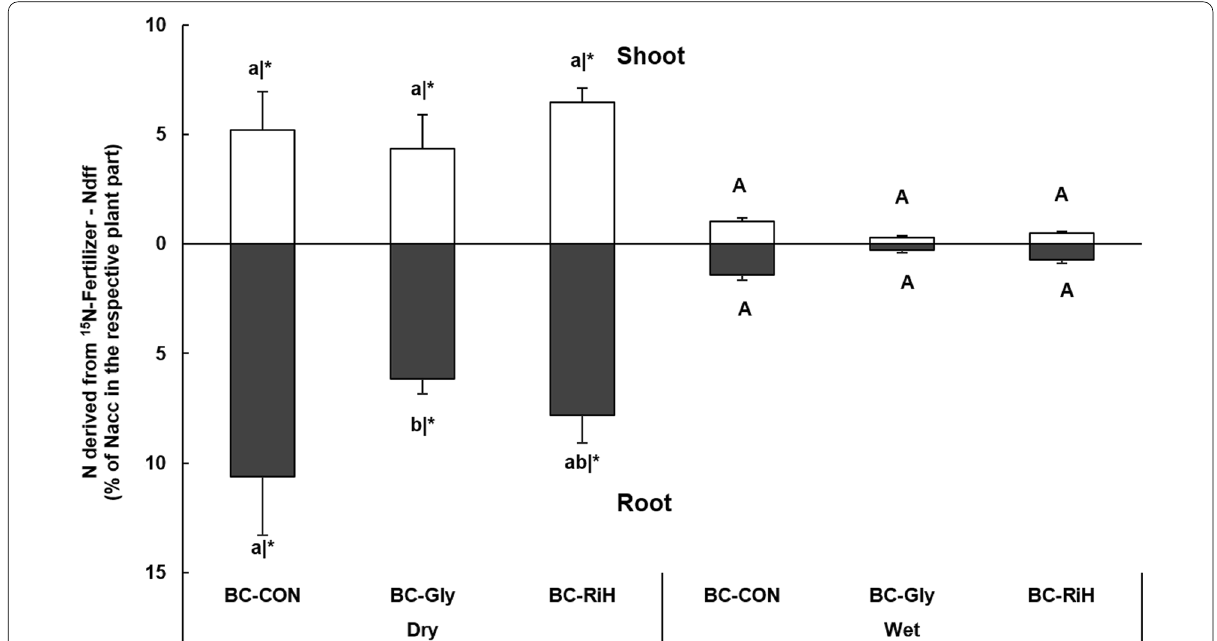
Fig. 3 15 N derived from 15 N labelled fertilizer (Ndff) expressed as the percentage of N in shoots (bars above the x-axis) and roots (bars below the x-axis). Different lowercase and capital letters indicate significantly different means (One-way ANOVA and LSD; p treatments under dry and wet moisture conditions, respectively. Asterisks * indicate significantly higher values in dry than in the wet moisture condition within a biochar treatment; Vertical bars represent standard errors of the means (n